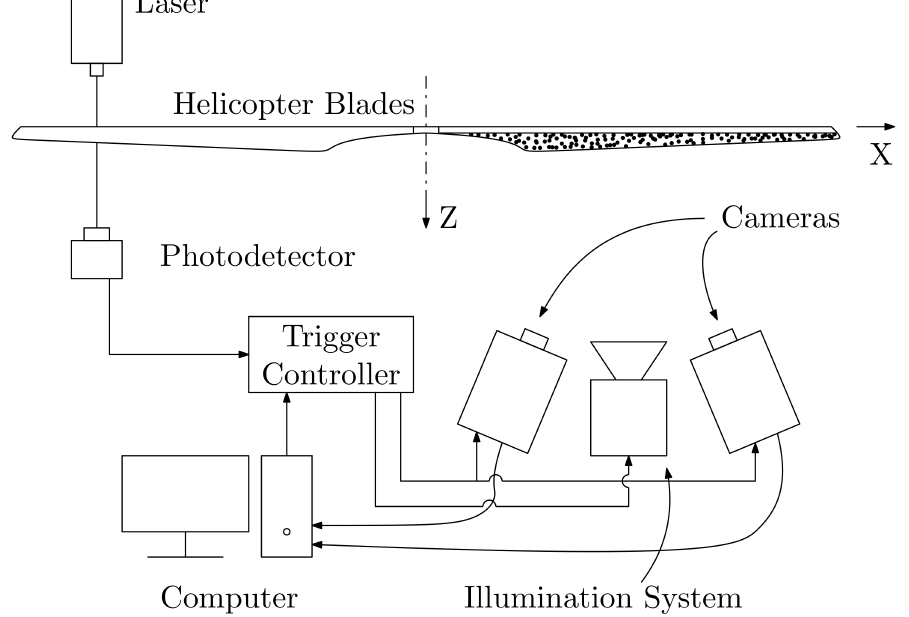
Figure 2. Schematic of the experimental setup employed for the new image sensing